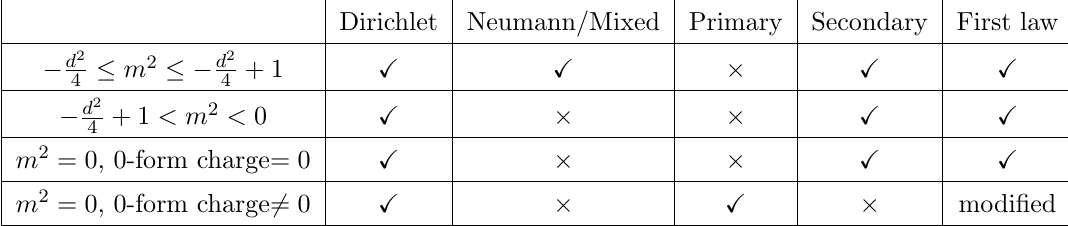
Table 1 . Classi(cid:12)cation of primary versus secondary scalar hair, in relation to the (cid:12)rst law of thermodynamics and the boundary conditions the scalar (cid:12)elds